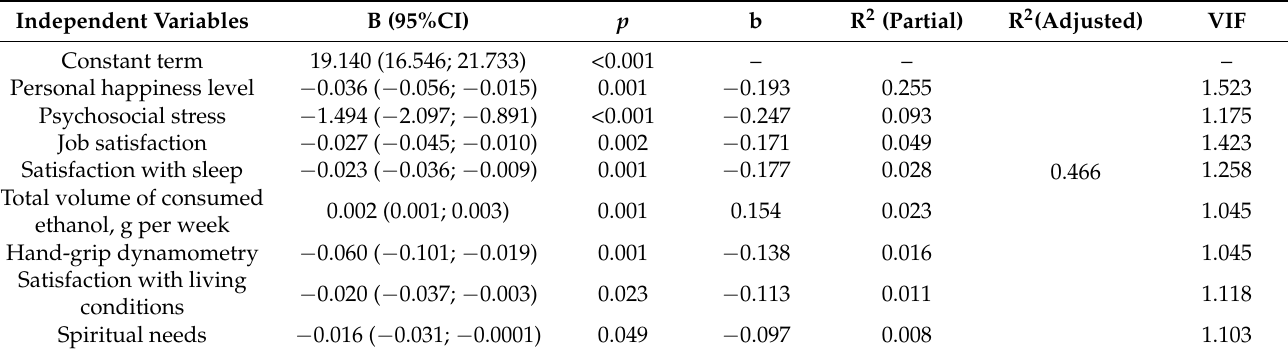
Table 6. Multiple linear regression of vital exhaustion association with indicators of psychosocial environment and lifestyle in 41–44-year-old